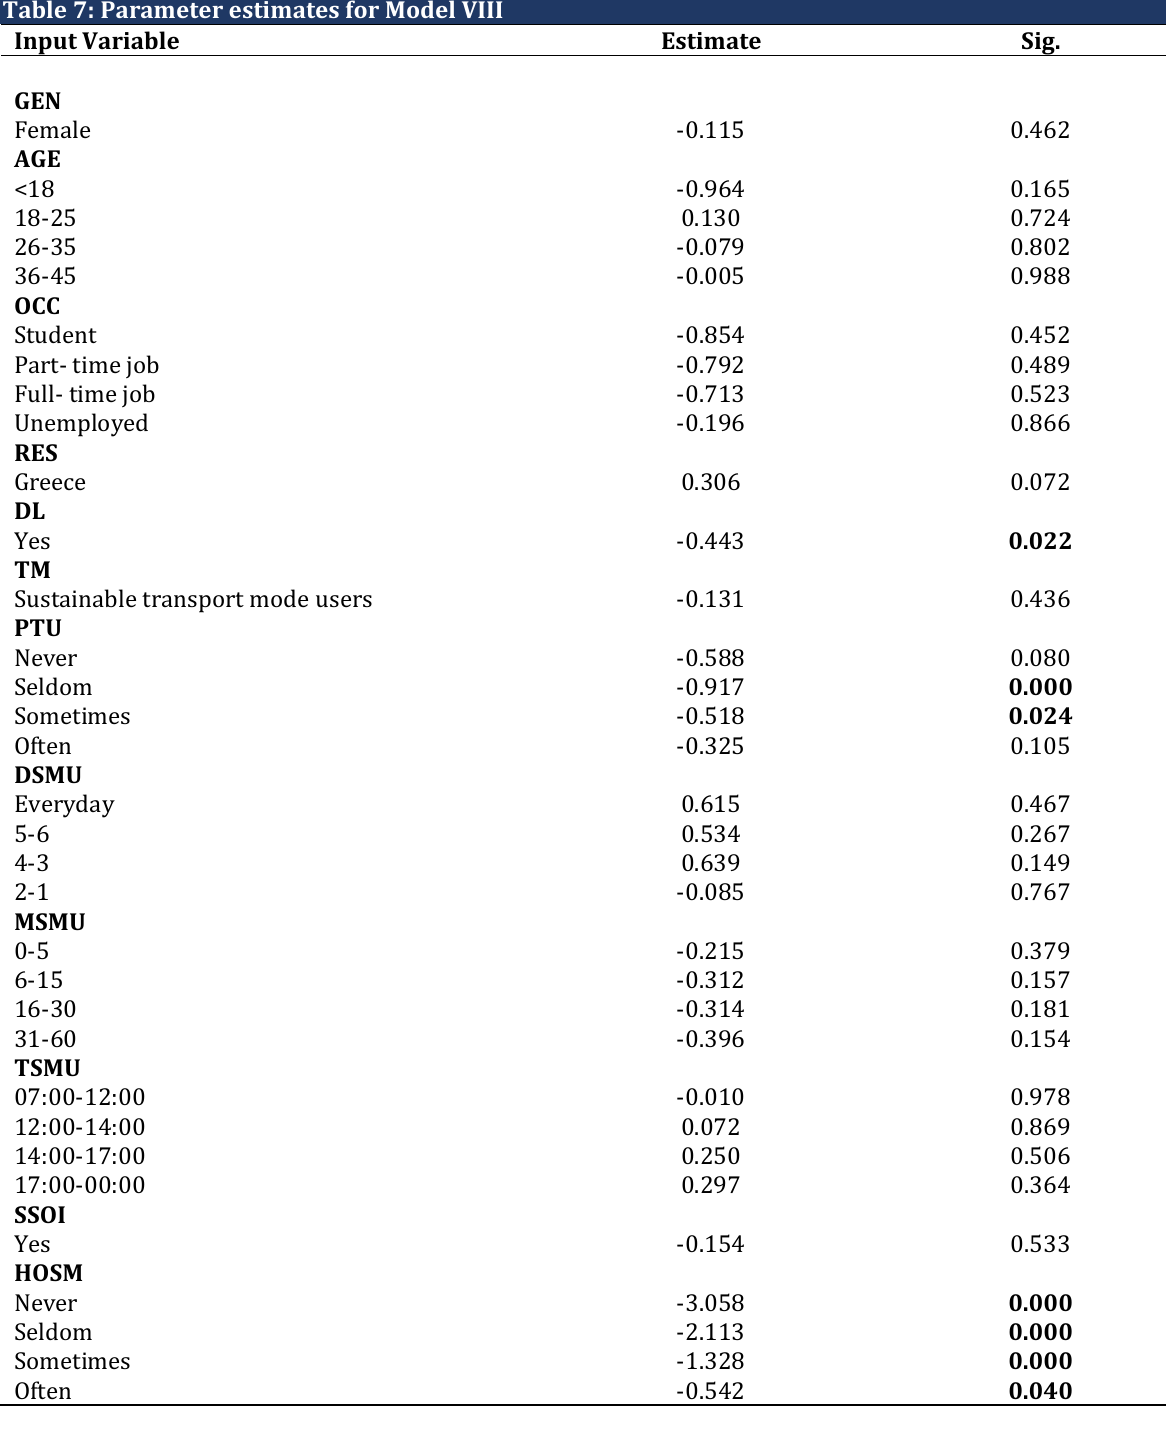
Table 7: Parameter estimates for Model